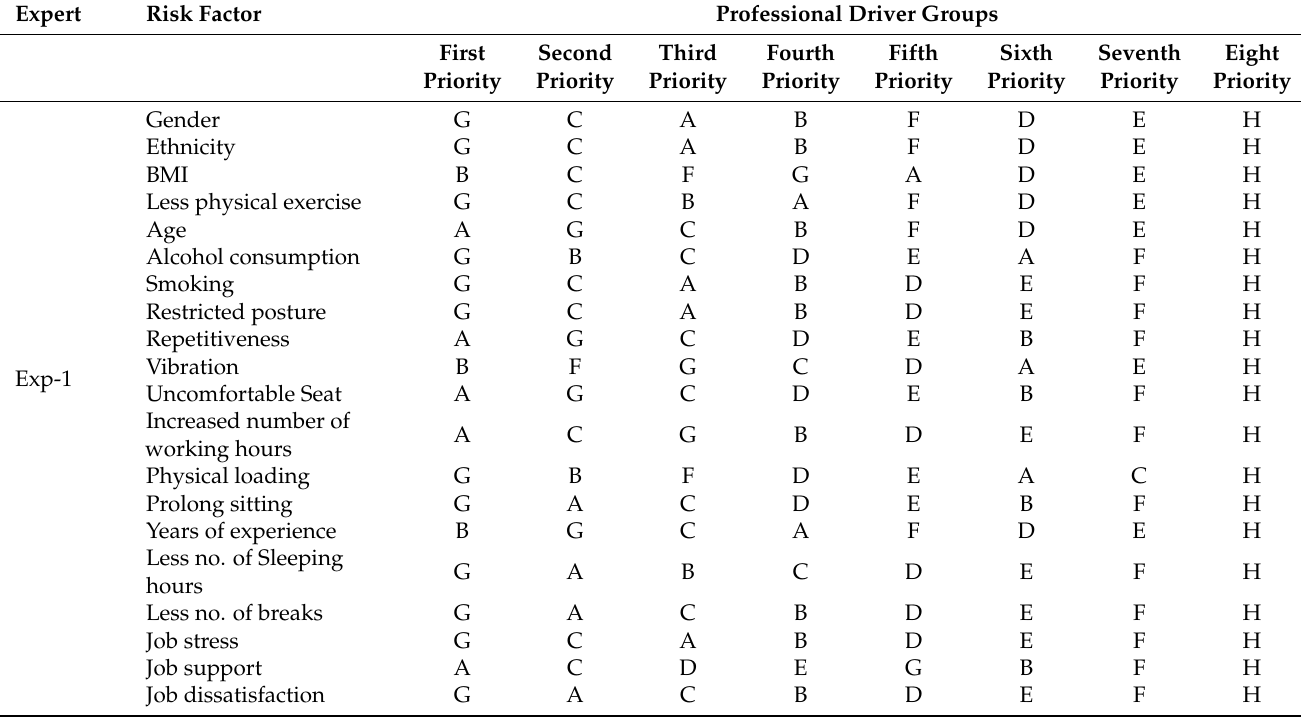
Table 7. Ranking of different professional driver groups based on the opinion of